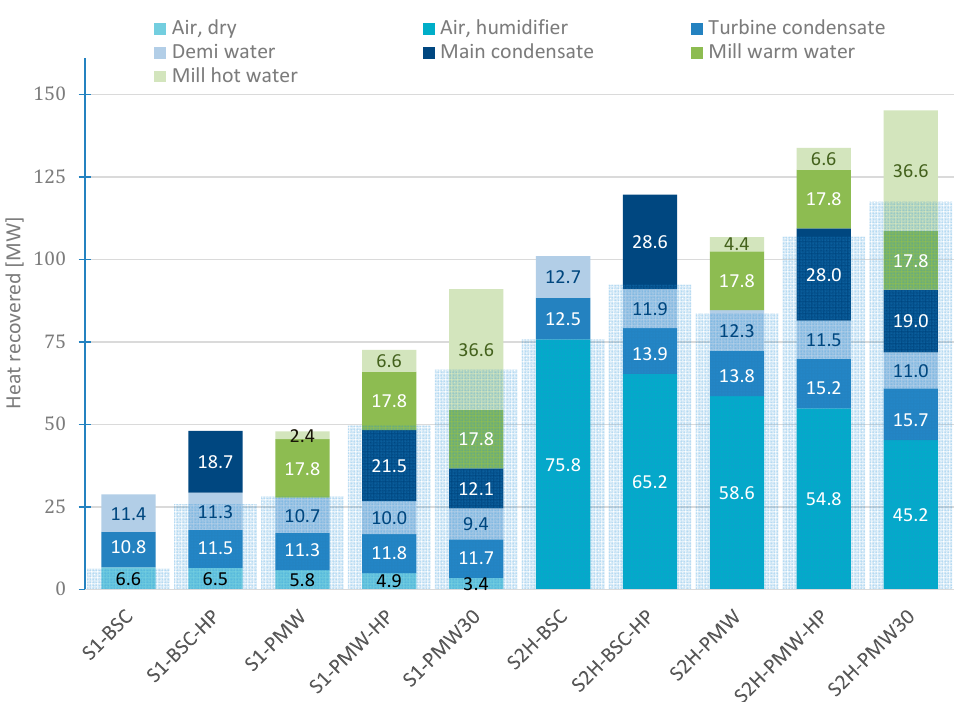
Figure 6. Division of recovered heat between different heat sinks in different heat recovery schemes. Wider semi-transparent light blue bars depict the fraction of heat recovered through condensation. When heat pumps are used (PMW30 and cases indicated with HP), these are used to transfer heat to the steam cycle main condensate and pulp mill hot water.